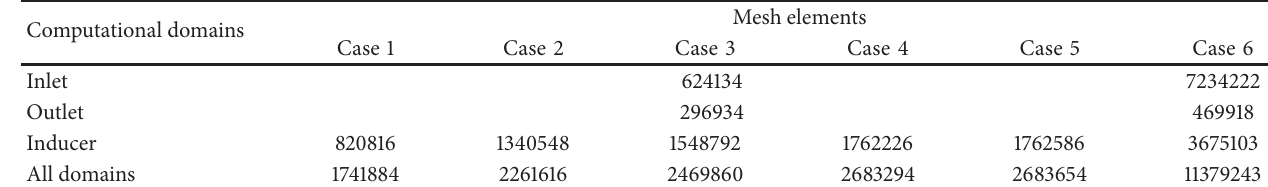
Table 3: Details of mesh elements.